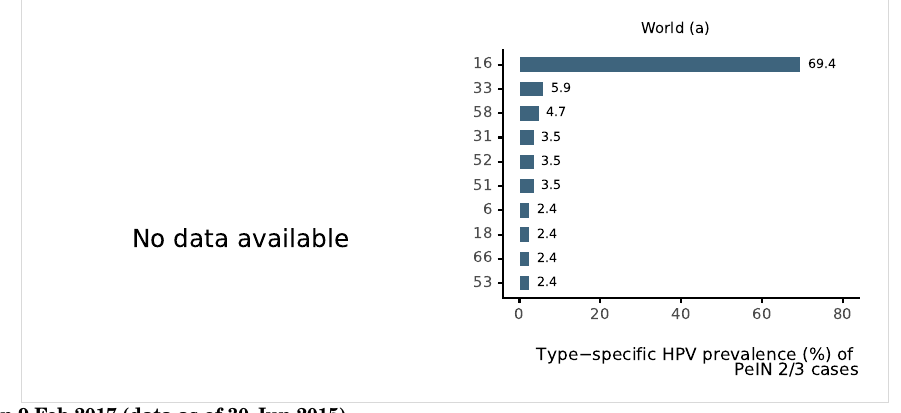
Figure 69: Comparison of the ten most frequent HPV types in PeIN 2/3 cases in Asia and the World